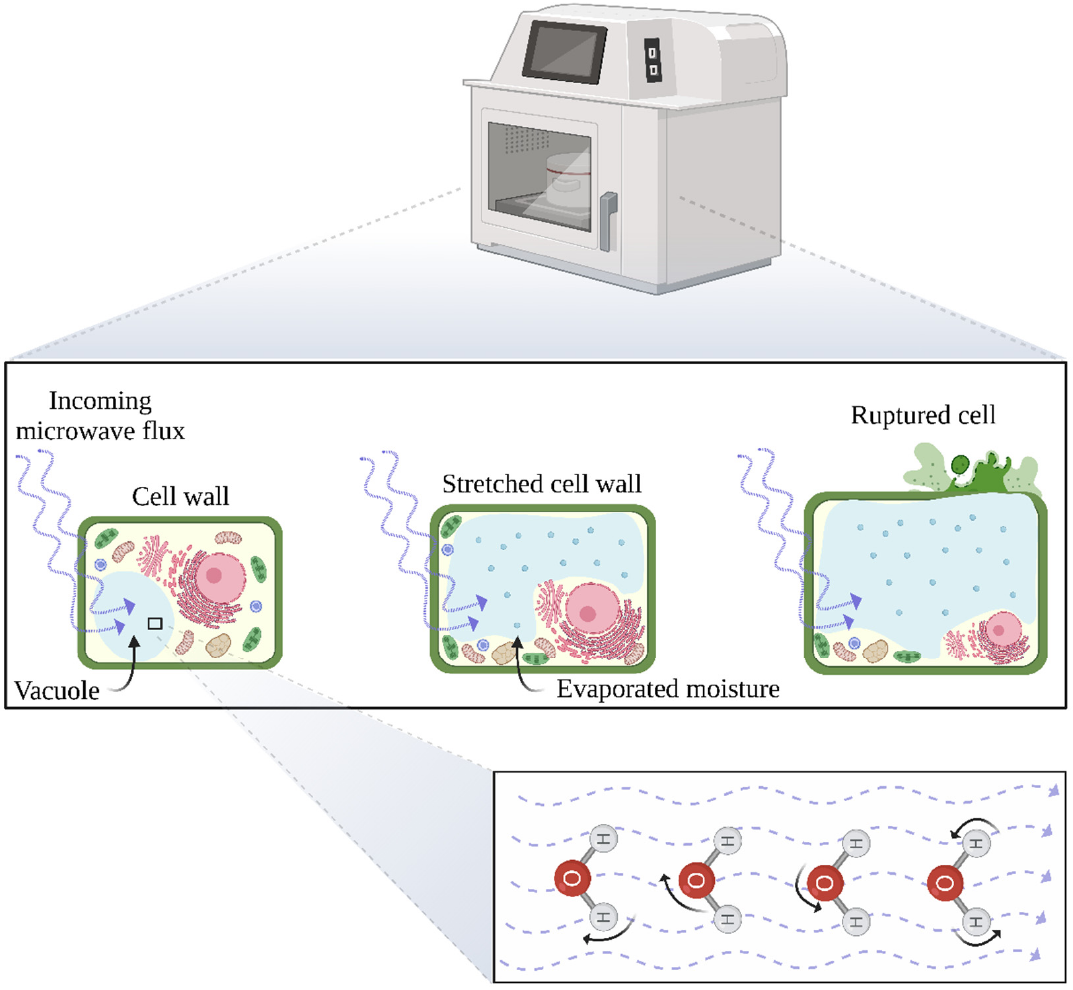
Figure 6. Microwave pretreatment’s principle of action.